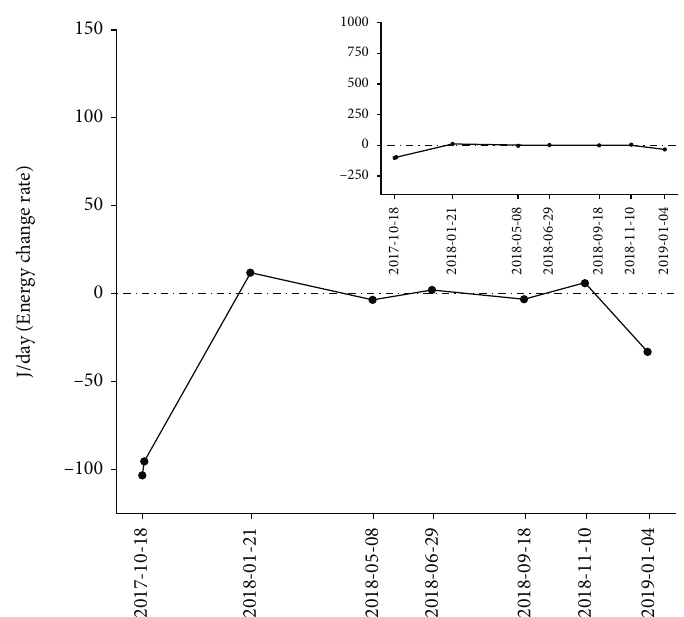
Figure 11: Change rate of kinetic energy in borehole